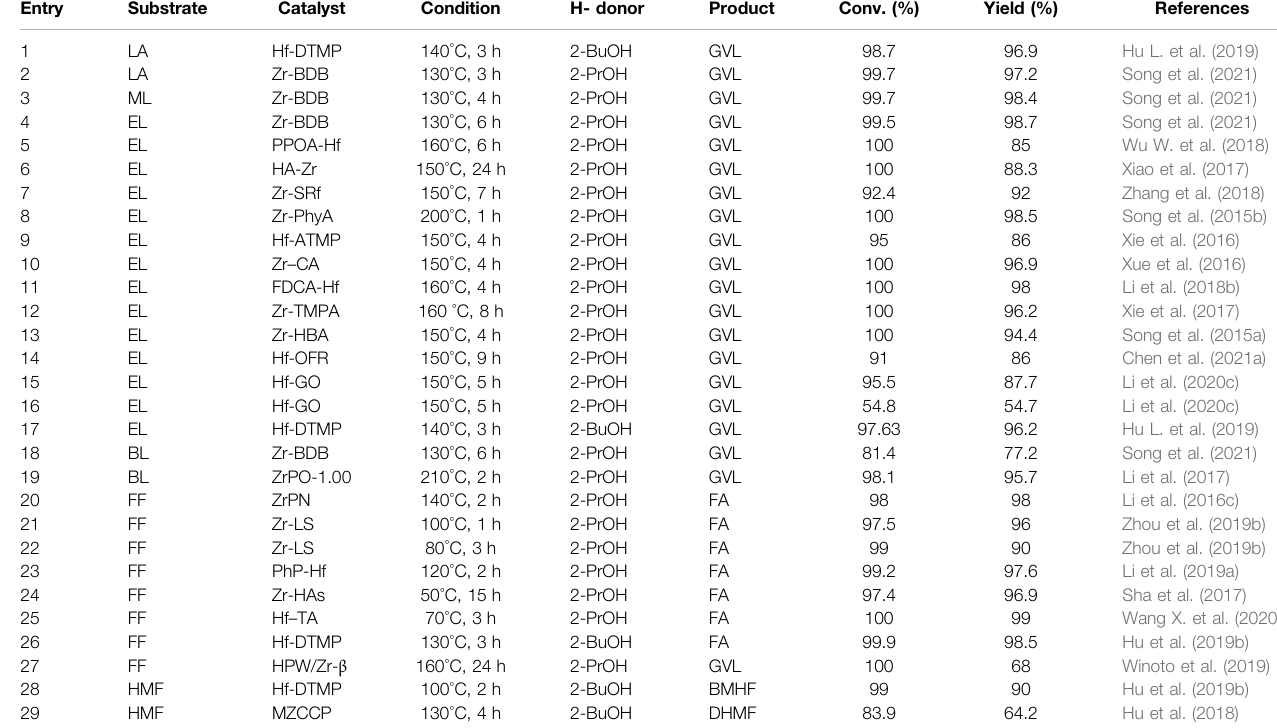
TABLE 5 | Zr/Hf-containing metal-organic hydride